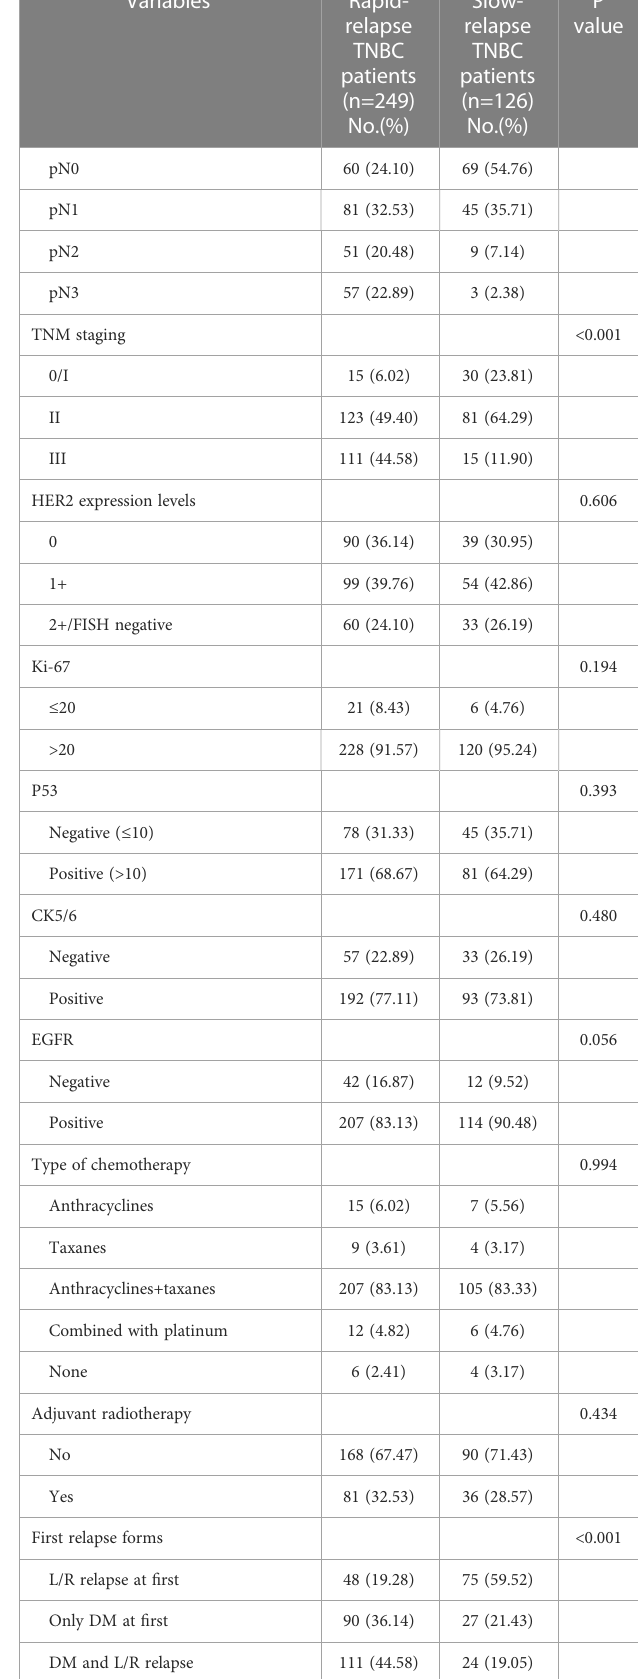
TABLE 1 The relapse and metastasis characteristics between RR-TNBC and SR-TNBC patients according to strati fi ed variables: univariate